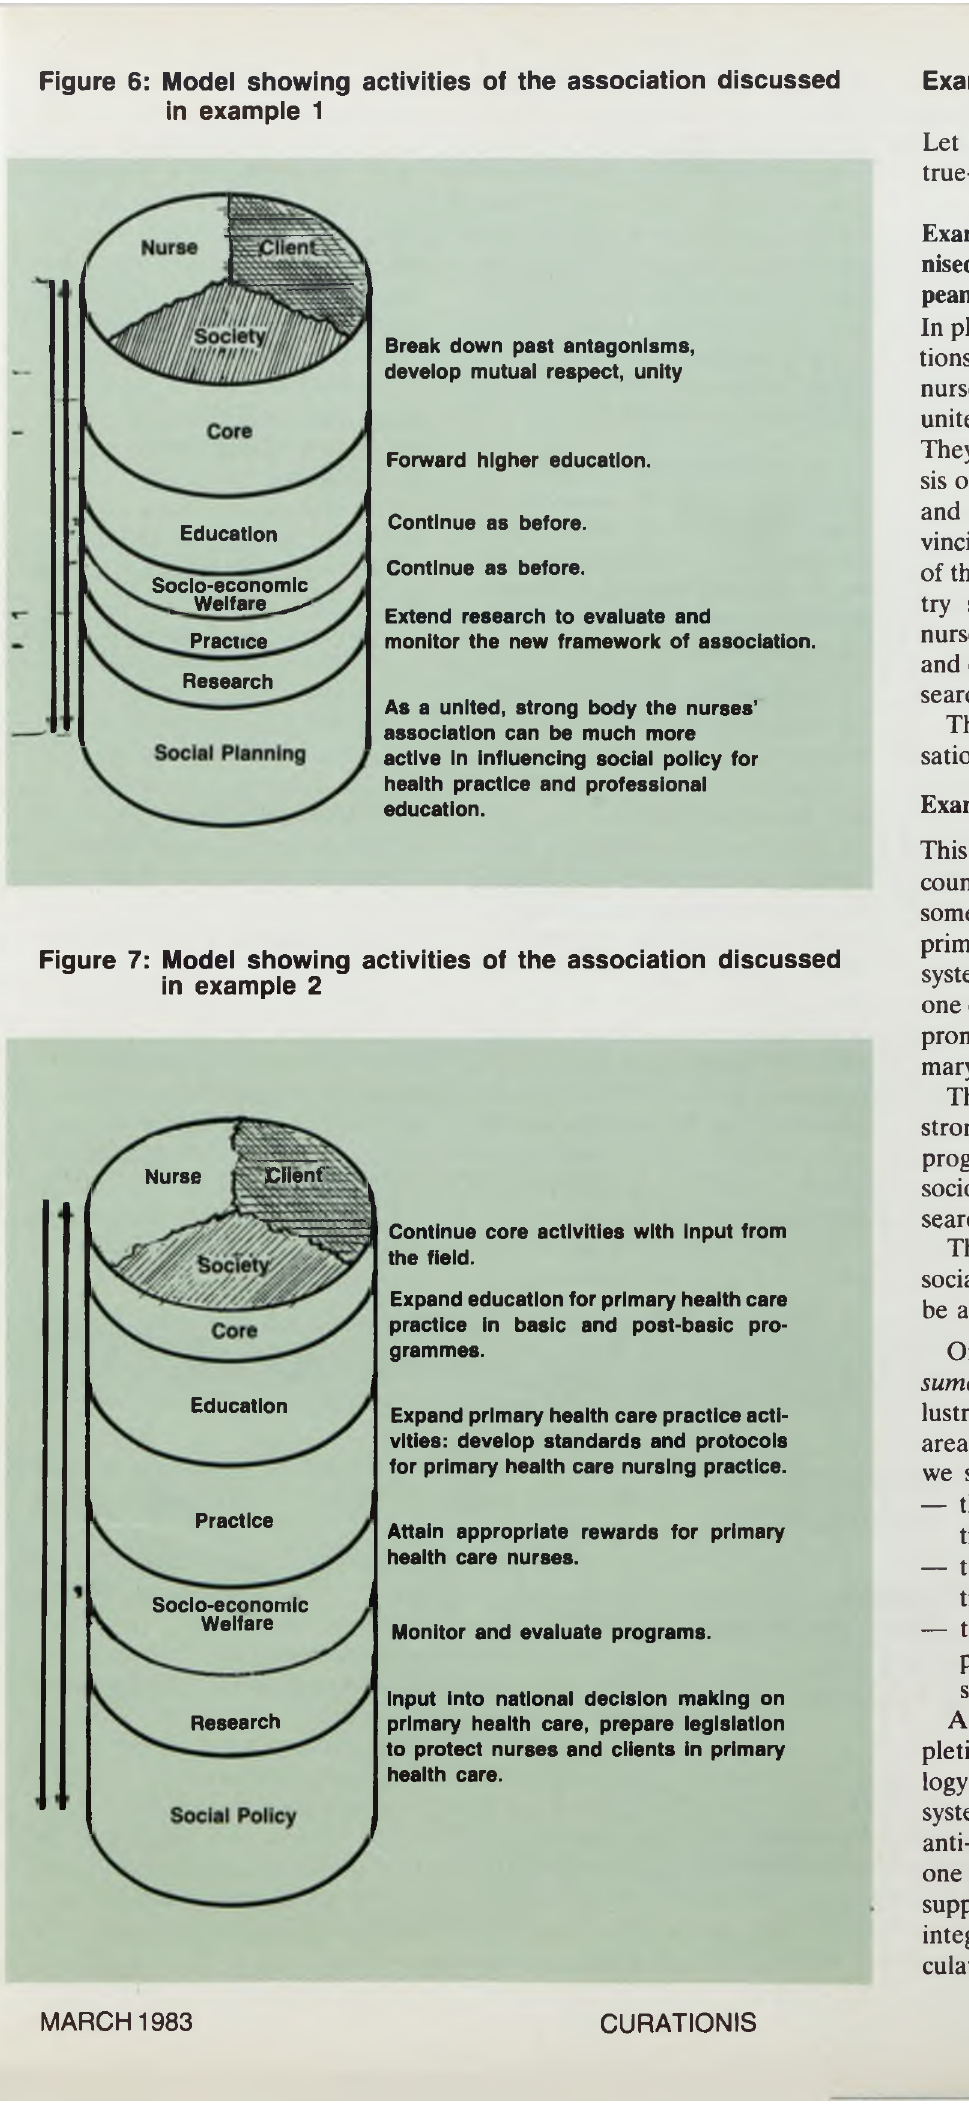
Figure 6: Model showing activities of the association discussed in example 1